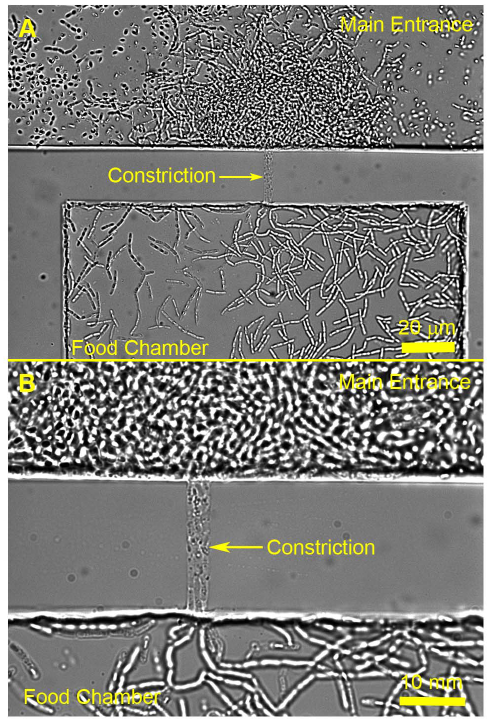
Figure 4. Isolation of Roseobactersp . from Psychroserpenssp . (a- b) Food chamber connected to main entrance containing heterogeneous bacterial sample via a 950 nm tall, 5 m m wide, and 30 m m long constriction. (a) Brightfield, 40x magnification. (b) Brightfield,100xmagnification. Bothspecies arepresentinthemainentrance. Only Roseobacter sp . cells are present in the constriction and food